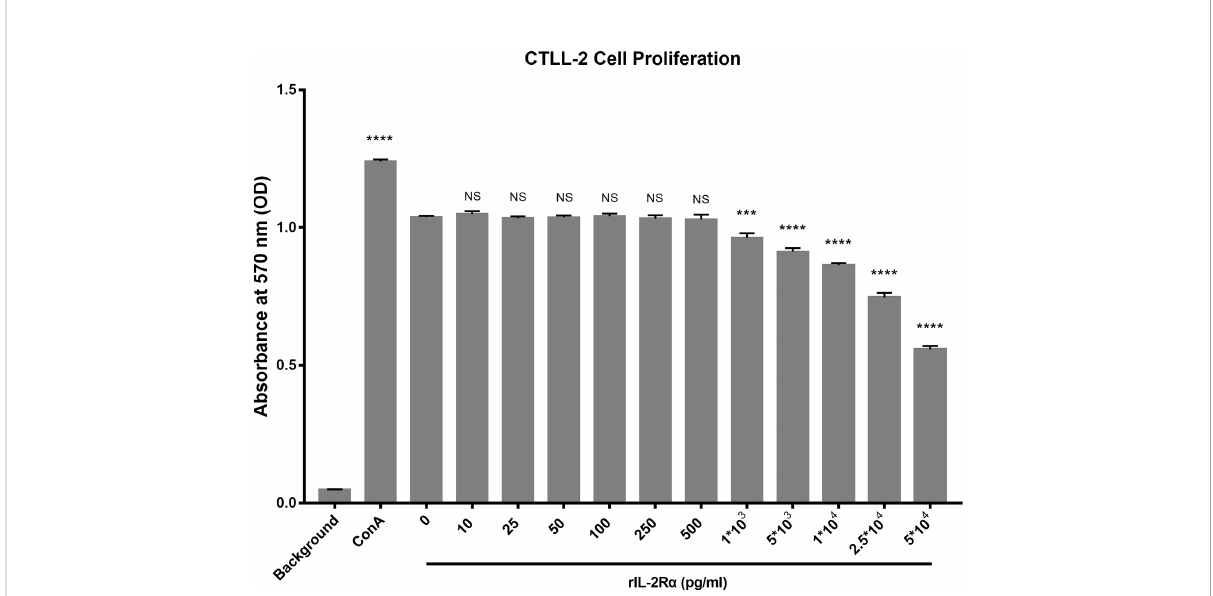
FIGURE 5 sIL-2R a suppressed the proliferation of CTLL-2 cells in vitro . CTLL-2 cells were cultured in medium containing IL-2 at the concentration of 6 pg/ml, with the addition of sIL-2R a at different concentration or Con A (10 m g/ml) for 18 h. Control wells containing no cells or CTLL-2 cells without IL-2 were designed as background and negative control. The cell proliferation was measured by MTT assay. Data were expressed as mean ± standard deviation (SD) of at least three independent experiments. Statistical signi fi cance was determined by one-way analysis of variance (ANOVA) followed by post hoc test. P value versus the negative control. “ NS ” means no signi fi cance; *p < 0.05; ***p < 0.001; ****p <